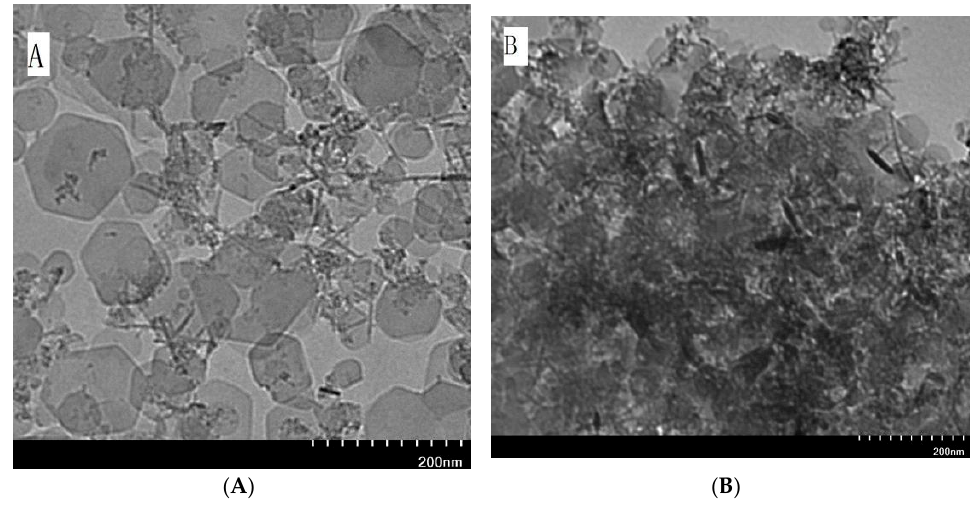
Figure 9. TEM images of ( A ) MgFe-LDH and ( B ) MgFe-LDH/dextranase.